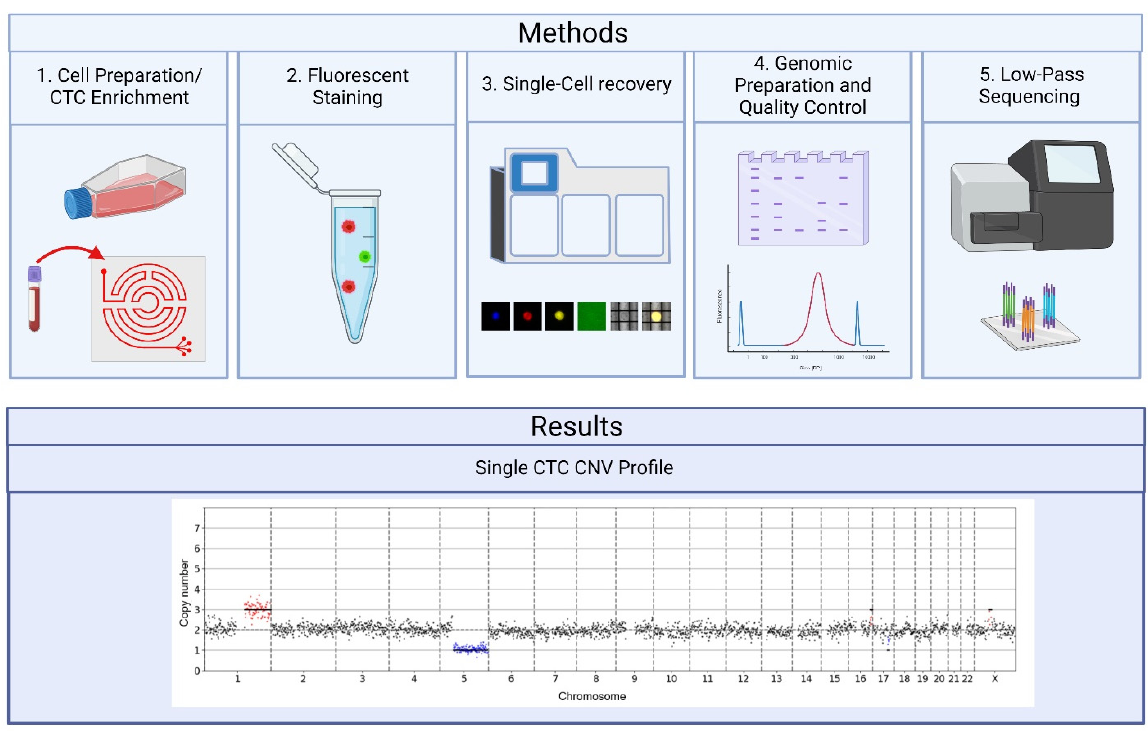
Figure 1. Study outline. 1: Cells are first obtained from culture (cell lines) or by processing blood through the Labyrinth to enrich for CTCs. 2: Cells are then fixed and fluorescently stained to allow for future cell identification. 3: The fixed cells are loaded onto the DEPArray for imaging and recovery of single cells. Cells are selected based on their fluorescent staining. 4: Single cells undergo whole genome amplification and library preparation to produce samples suitable for sequencing. The quality of the samples is confirmed after each step. 5: Samples are sequenced using an Illumina MiSeq. Results: Fastq files were submitted to MSBiosuite, which processed the data and provided single CNV profiles for each